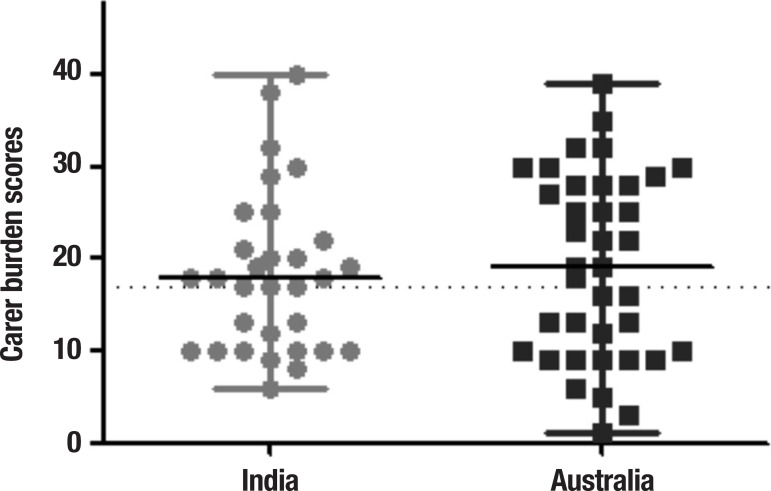
Carer burden scores on the Zarit Burden Inventory in India and Australia
represented in medians and interquartile ranges. Dotted line represents
clinical cut off for high burden. Mann-Whitney tests, p<0.05.